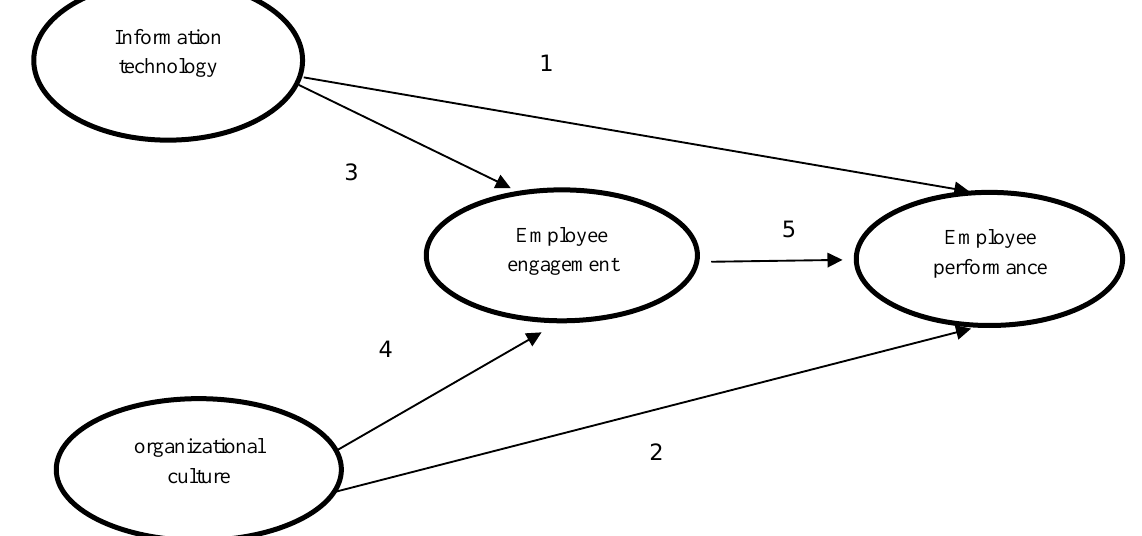
Figure 1: Conceptual Model of the Study; Source: Authors